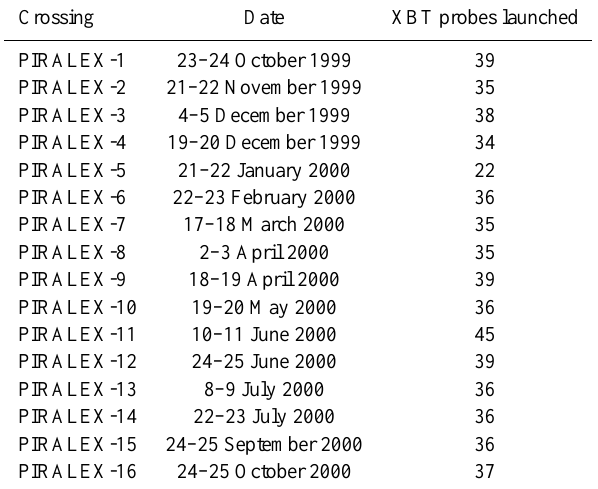
Table 1. XBT PIRAEUS – Alexandria crossings